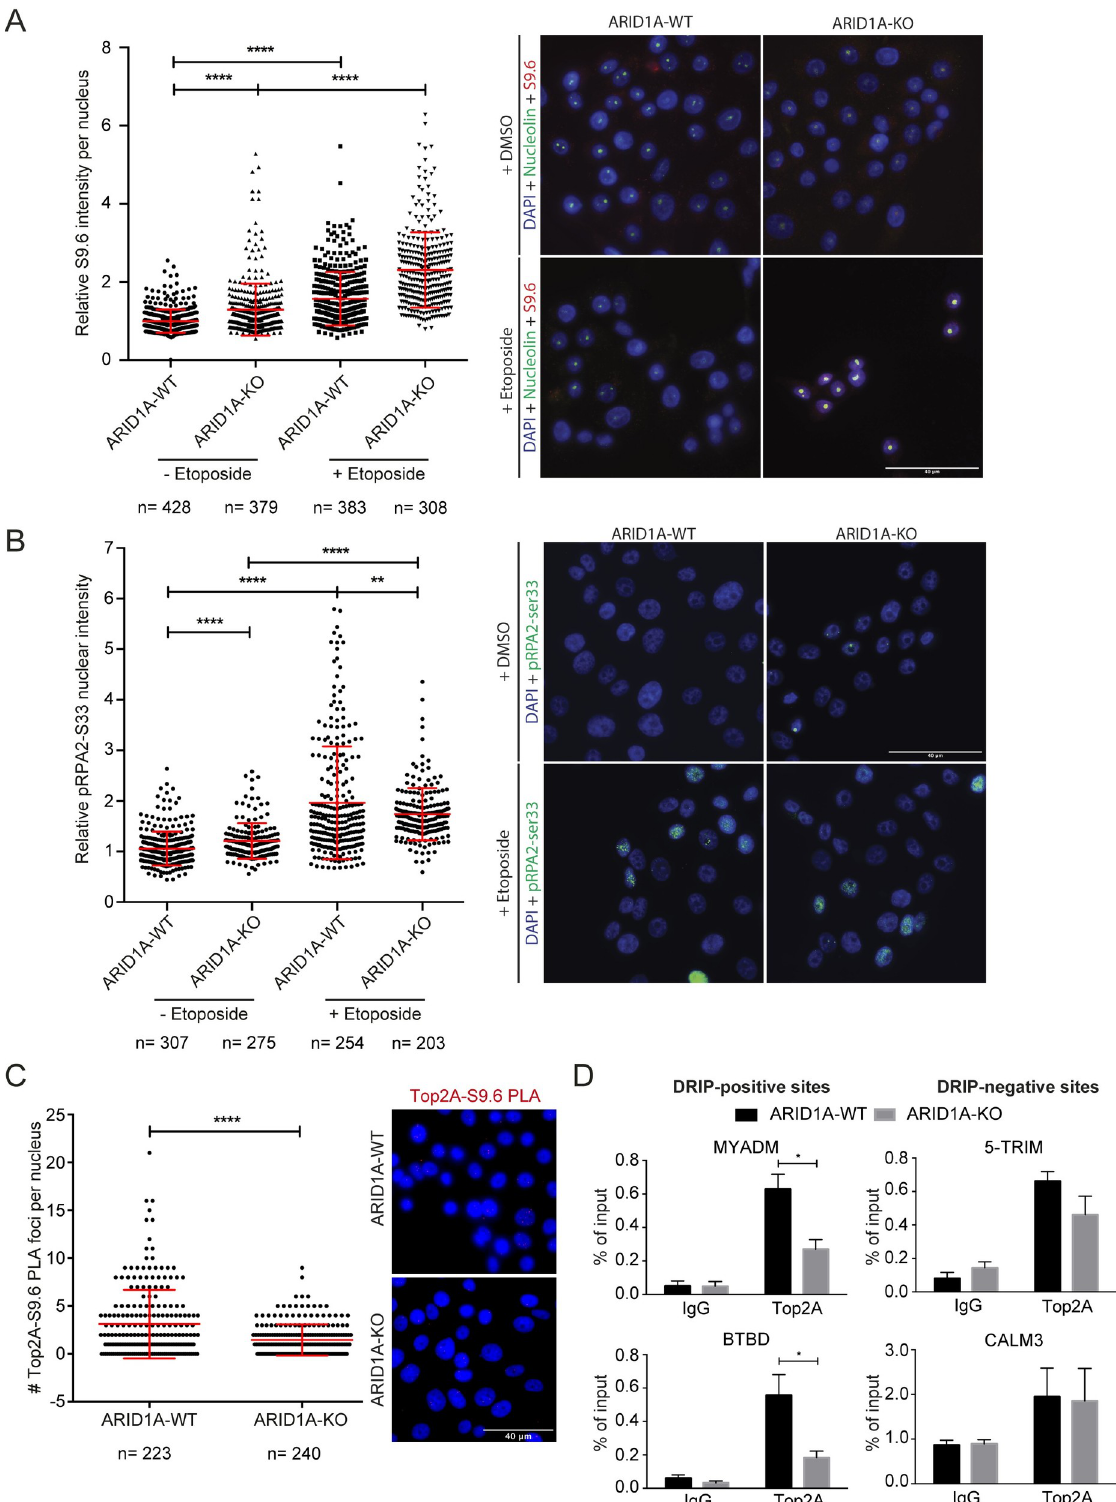
Fig 4. TOP2A loss from R-loop sites in ARID1A-KO cells. (A) Quantification of relative S9.6 nuclear intensity in WT and ARID1A-KO RMG1 cells treated with or without Etoposide (10 μ M, 2 hours). Nucleolar S9.6 staining was subtracted from the total nuclear